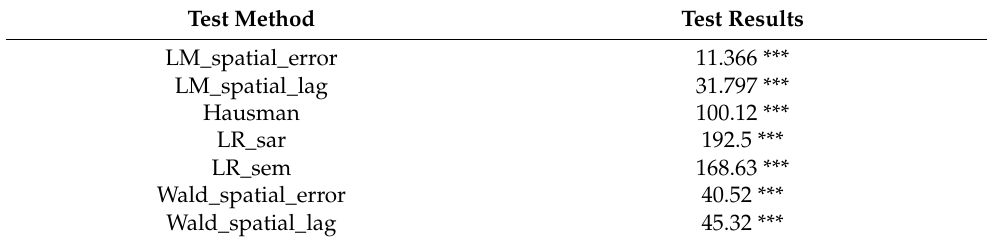
Table 3. Test results of the spatial panel model.